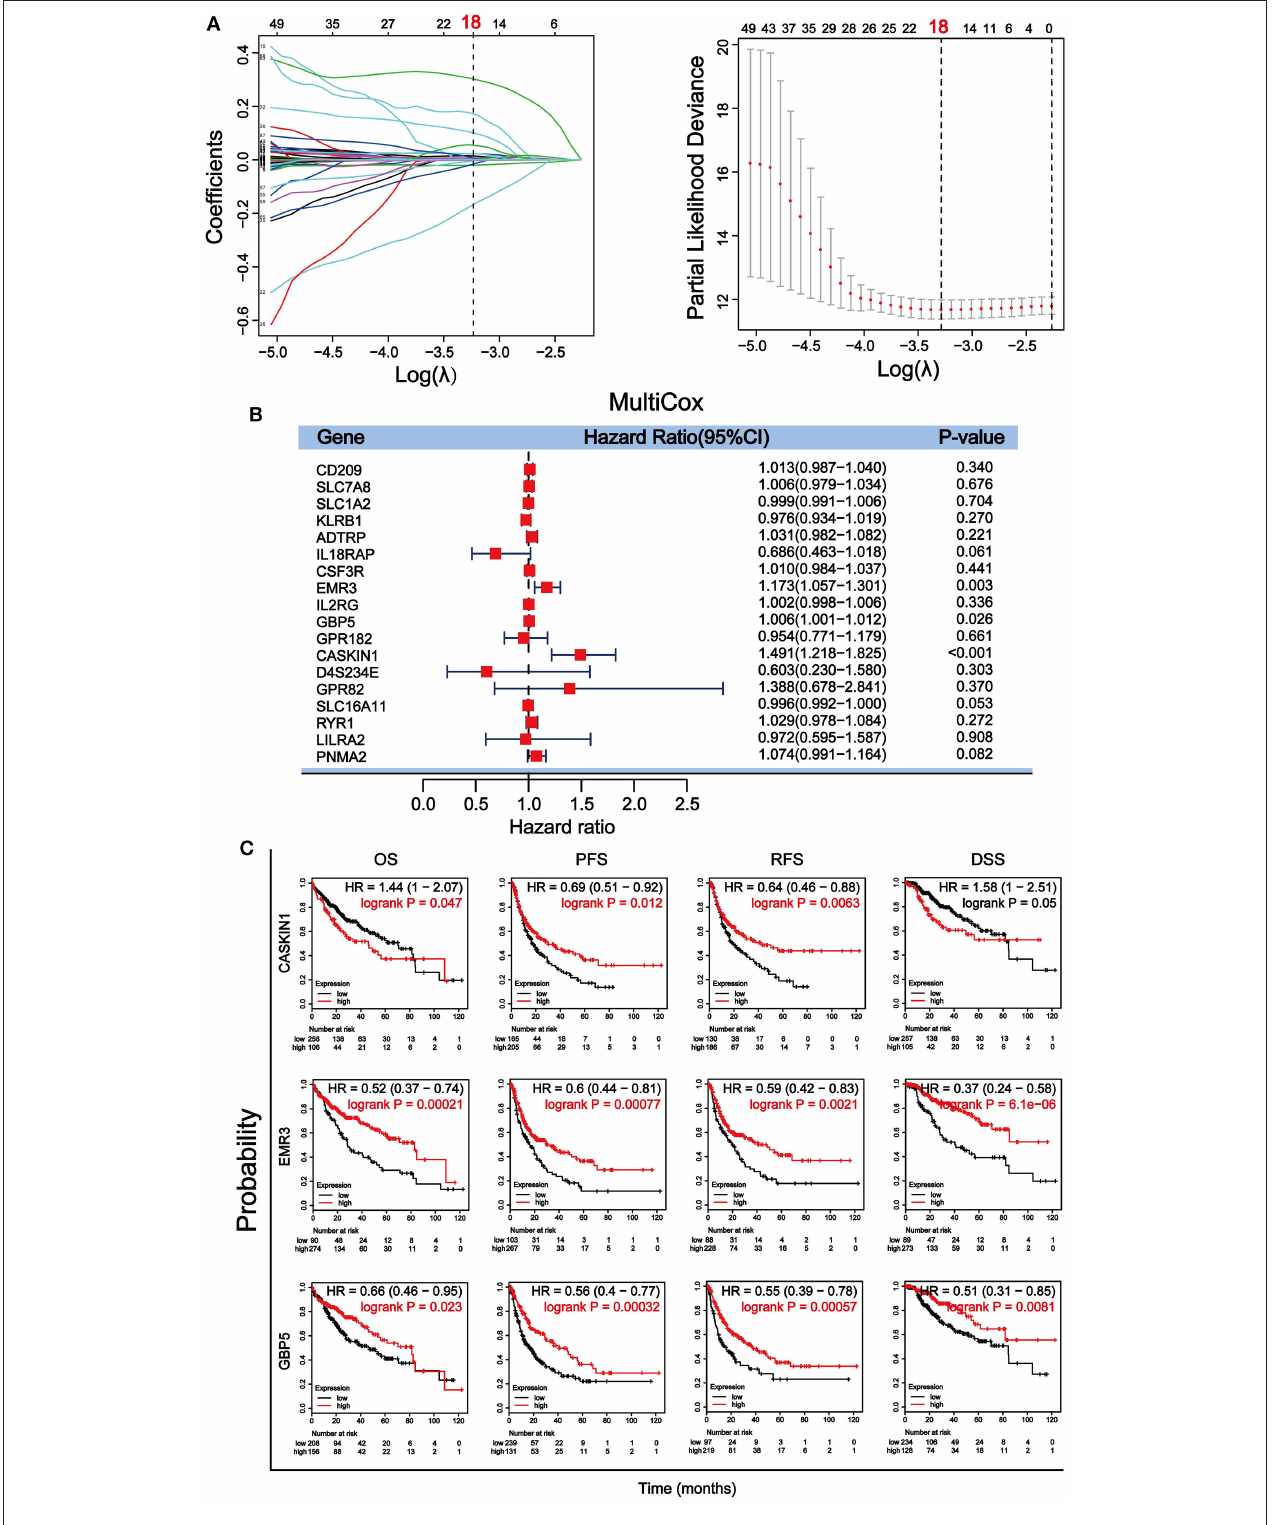
FIGURE 4 | Screening and verification of prognostic genes in HCC. (A) Least absolute shrinkage and selection operator (LASSO) regression analysis was used to screen for genetic variables. The dotted line indicates the number of genes after screening. (B) Multivariate Cox regression analysis was used to further screen genes that can be used as independent prognostic factors. The value, p < 0.5 was considered statistically significant. (C) Survival verification of the three selected genes by Kaplan–Meier plotter database in HCC. Prognostic indicators include overall survival (OS), progression-free survival (PFS), relapse-free survival (RFS), disease-specific survival